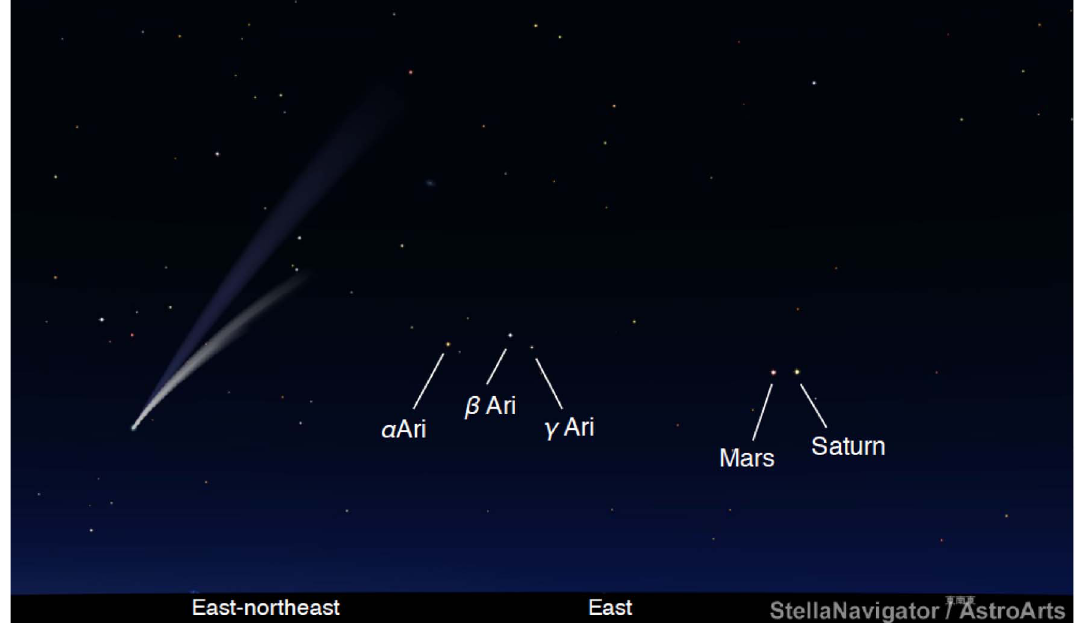
Fig. 7. Computed appearance of cometary tails on 760 May 24/25 at Amida, using Stellar Navigator 11 with the orbital elements in Yeomans & Kiang (1981) and Marsden & Williams